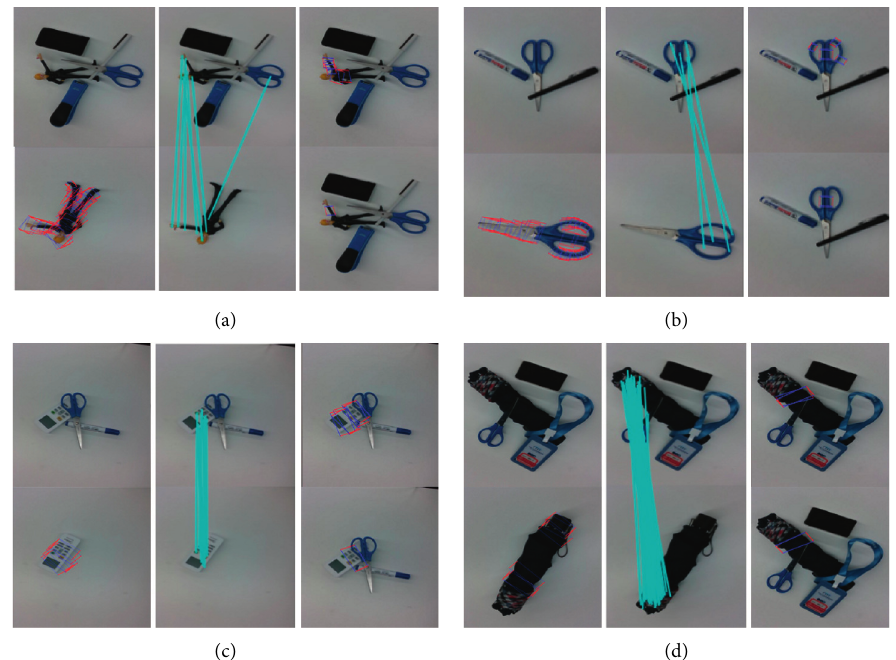
Figure 8: Grasp detection results on household objects under occlusions: (a) detection results of a garage kit, the first row of (a) is the input information and template information, the target object on scene image is occluded by other objects, and the template image only contains the target object and its grasp configurations; the second row shows the SIFT feature pairs obtained by our matching algorithm, and we connect each matching SIFT features using a blue line; and the last row is the detecting results with multiple-rectangle above and most suitable rectangle below, and all the results avoid the occluded parts. (b), (c), and (d) have the same layout. We connect the matching features using blue lines.